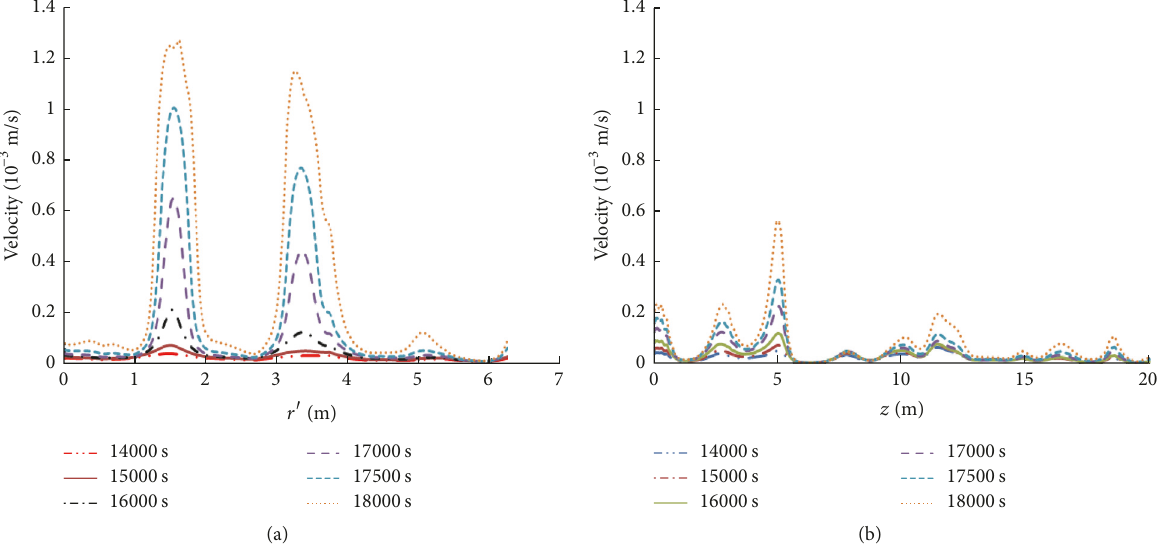
Figure 18: Evolution of seepage velocity along the lines of (a) O-O 󸀠󸀠 axis and (b) O 󸀠 -A 󸀠